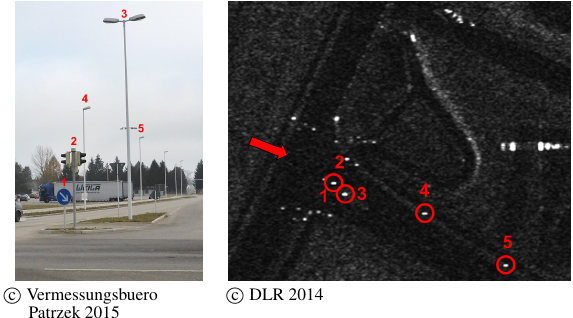
Figure 1. On-site inspection vs. spaceborne SAR; left: photo of a road junction in Oberpfaffenhofen (Germany); right: close-up of this junction in a TerraSAR-X High Resolution Spotlight (HS300) image; a red arrow marks the viewing direction of the optical image. Some prominent posts (labels 1–5) are likewise identifiable in photo and SAR